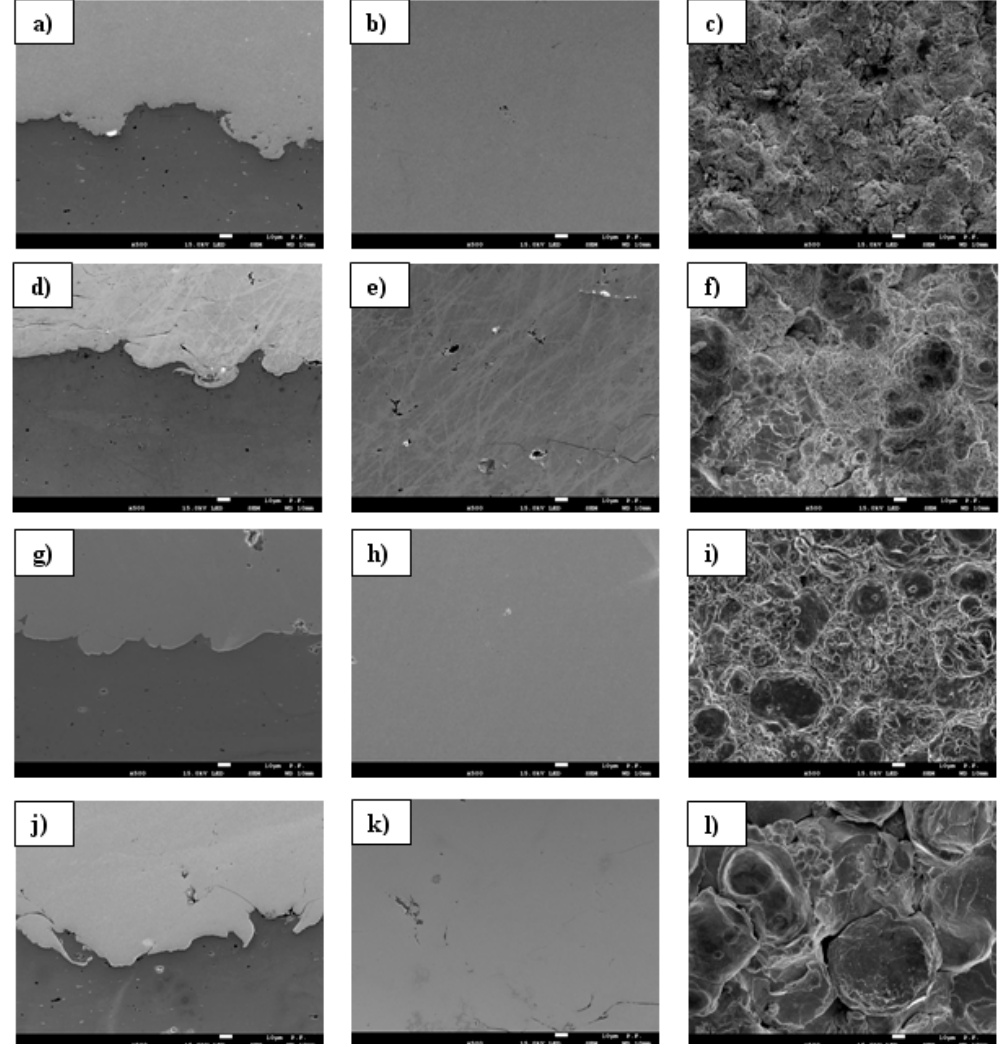
Figure 4. Cross-section and surface morphology of cold-sprayed Ni coatings: ( a – c ) C30 ; ( d – f ) M28 ; Figure 4. Cross ‐ section and surface morphology of cold ‐ sprayed Ni coatings: ( a ), ( b ), ( c ) C30 ; ( d ), ( e ), ( g – i ) A34 ; ( j – l ) O60 , respectively. Metals 2019 , 9 , x FOR PEER REVIEW ( f ) M28 ; ( g ), ( h ), ( i ) A34 ; ( j ), ( k ), and ( l ) O60 , respectively.